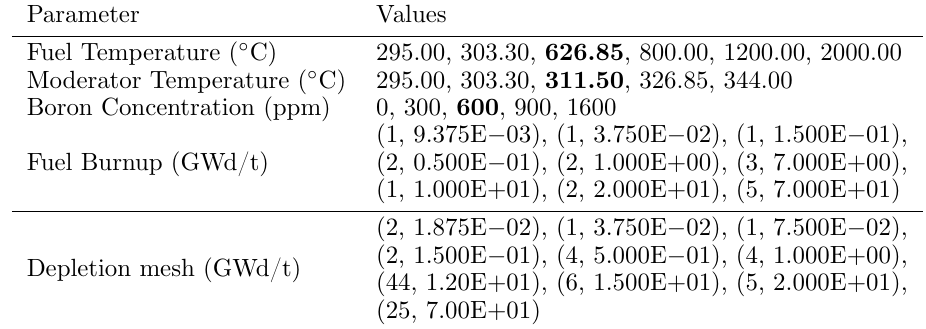
Table 1. List of values used for the 4-dimensional few-group